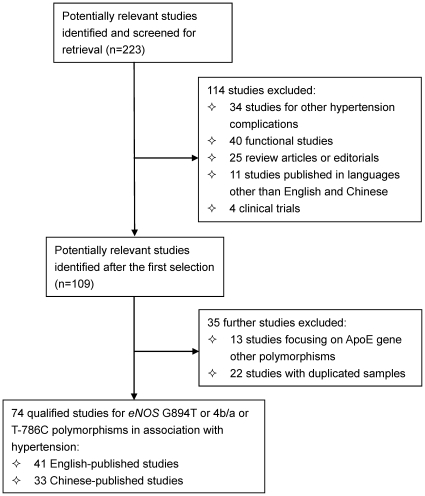
Flow diagram of search strategy and study selection.